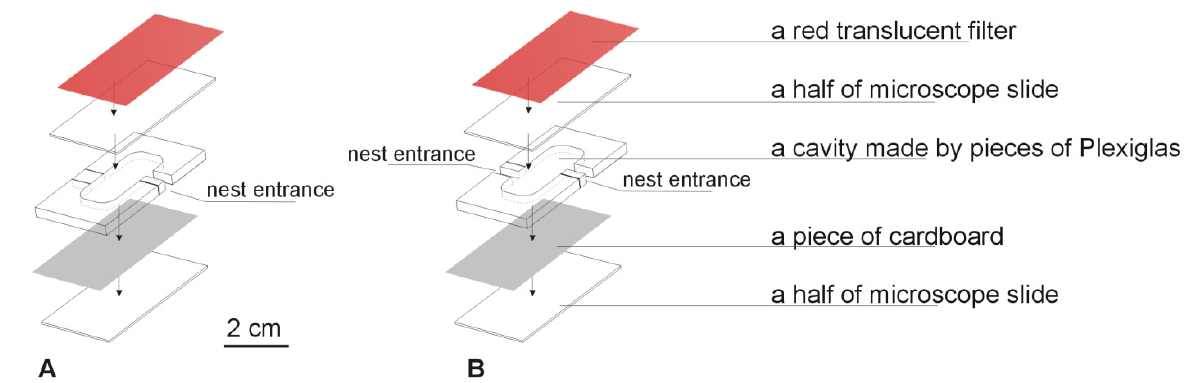
Figure 3. Nest design of the artificial nest sites used during the laboratory experiment: a cavity is created between a piece of cardboard and a 1/2 microscope slide (38 mm × 26 mm), which is kept apart by several pieces of Plexiglas as a frame (3 mm-thick) and coated with a piece of a red translucent filter. The volume of the cavity is ca. 0.78 cm 3 . Two types of nest sites were used: ( A ) with one entrance; and ( B ) with two entrances.